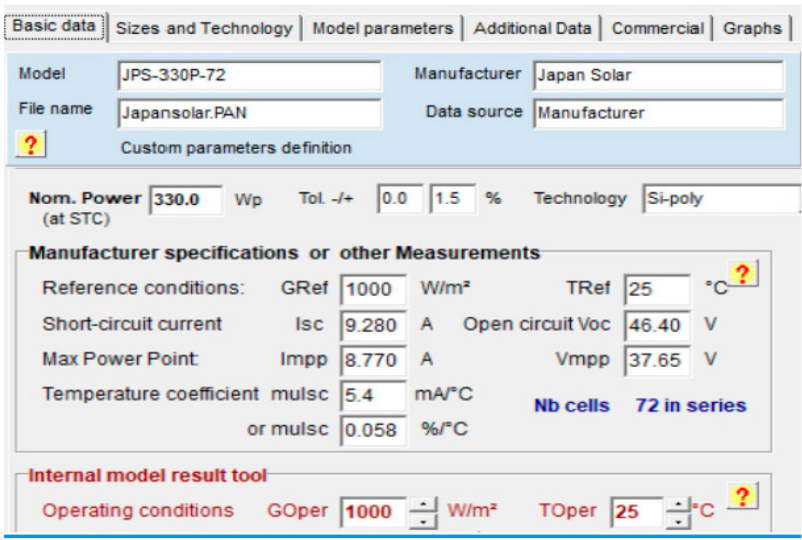
Figure 7. Basic data of the JPS-330P-72 used in the PVSyst simulation.